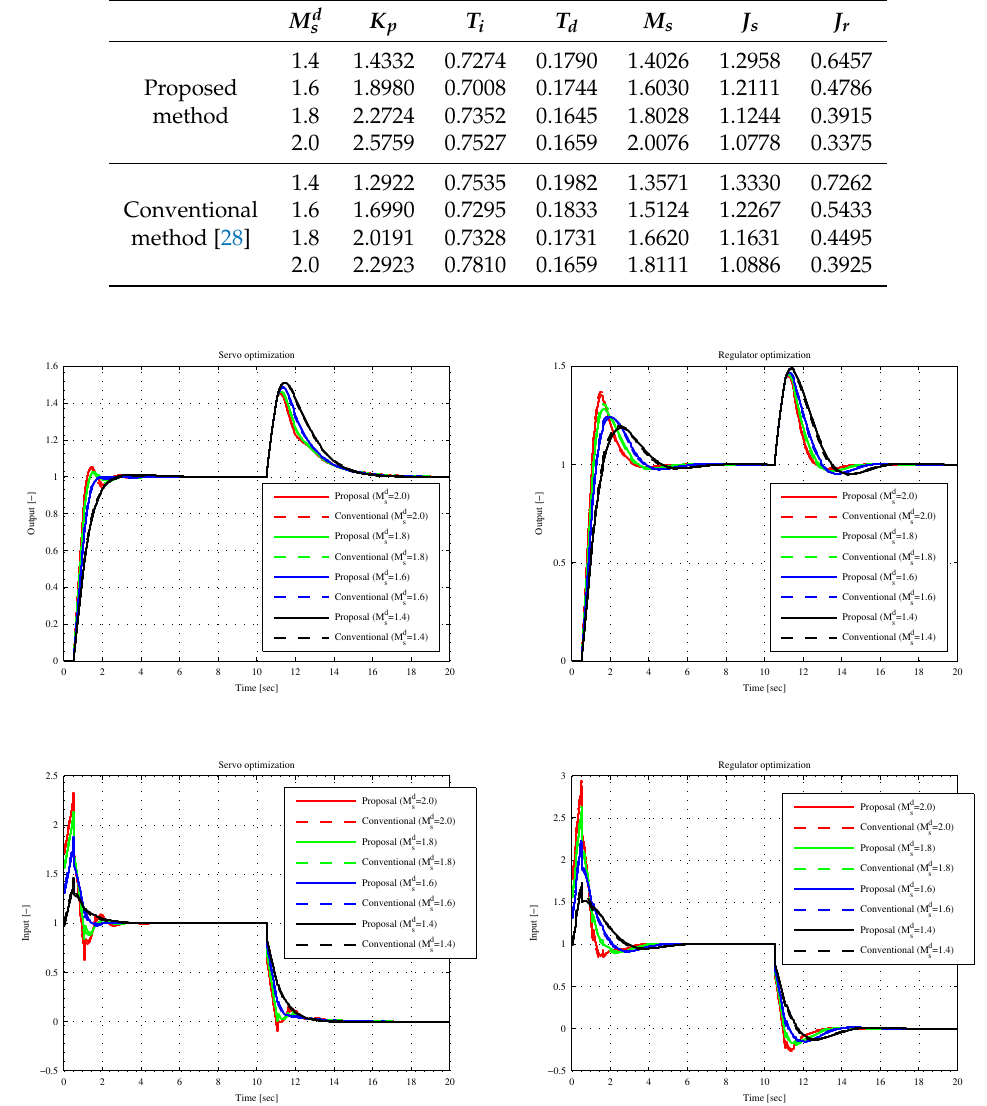
Figure 9. Output and input trajectories for the proposed and conventional designs for Equation (44), where the system is disturbed by a unit step disturbance after 10 s; left: servo optimization; right: regulator